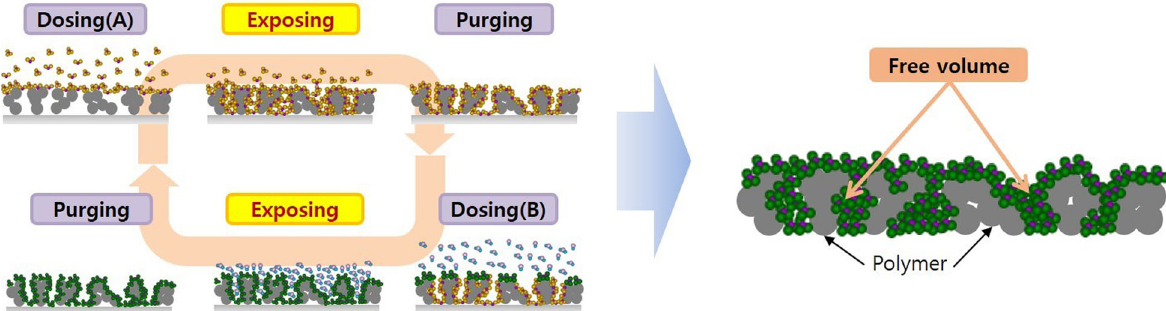
Fig. 1 Atomic layer in fi ltration. Atomic layer in fi ltration (ALI) process sequence for polymer-inorganic hybrid nanolayer fabrication by repeating the dosing, exposing, and purging